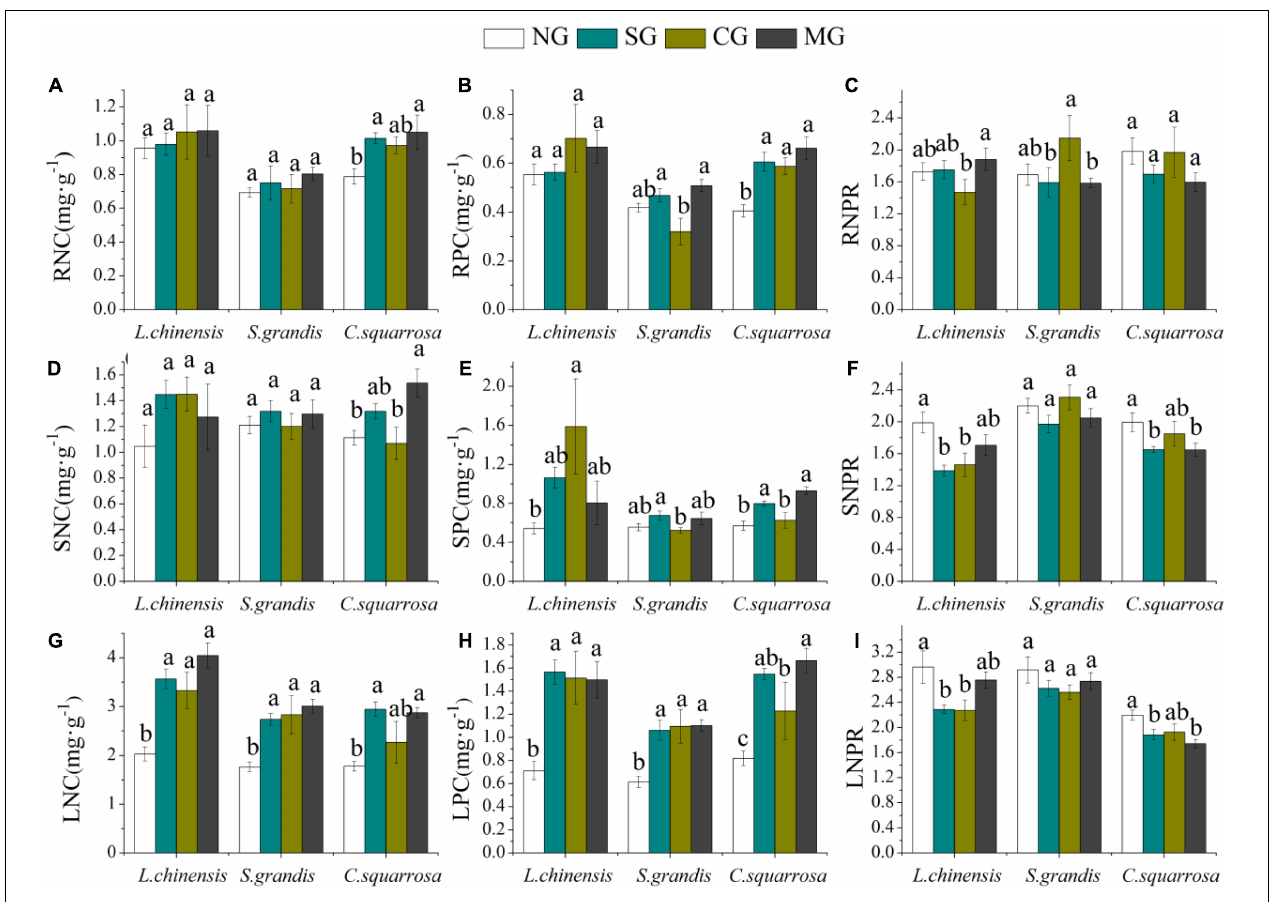
FIGURE 2 | Chemical traits of dominant species in different plots (SG, sheep grazing; CG, cattle grazing; MG, mixed grazing with cattle and sheep; NG, no grazing) showing (A) Root nitrogen concentration, (B) Root phosphorus concentration, (C) Root nitrogen: phosphorus ratio, (D) Stem nitrogen concentration, (E) Root phosphorus concentration, (F) Stem nitrogen: phosphorus ratio, (G) Leaf nitrogen concentration, (H) Leaf phosphorus concentration, (I) Leaf nitrogen: phosphorus ratio. In each graph, means with the same lowercase letters are not significantly different among plots ( P > 0.05); means with different lowercase letters are significantly different among plots ( P < 0.05). Capped lines represent ± standard